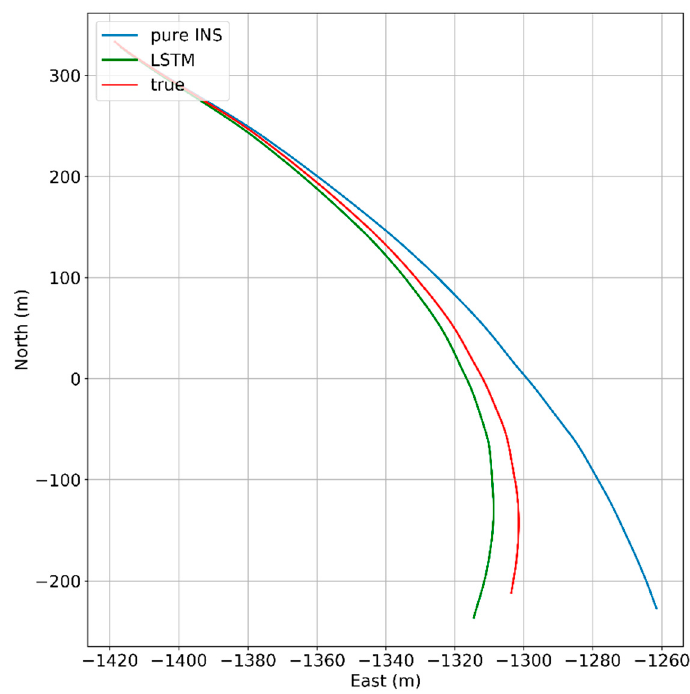
Figure 15. 60 s outages trajectory.